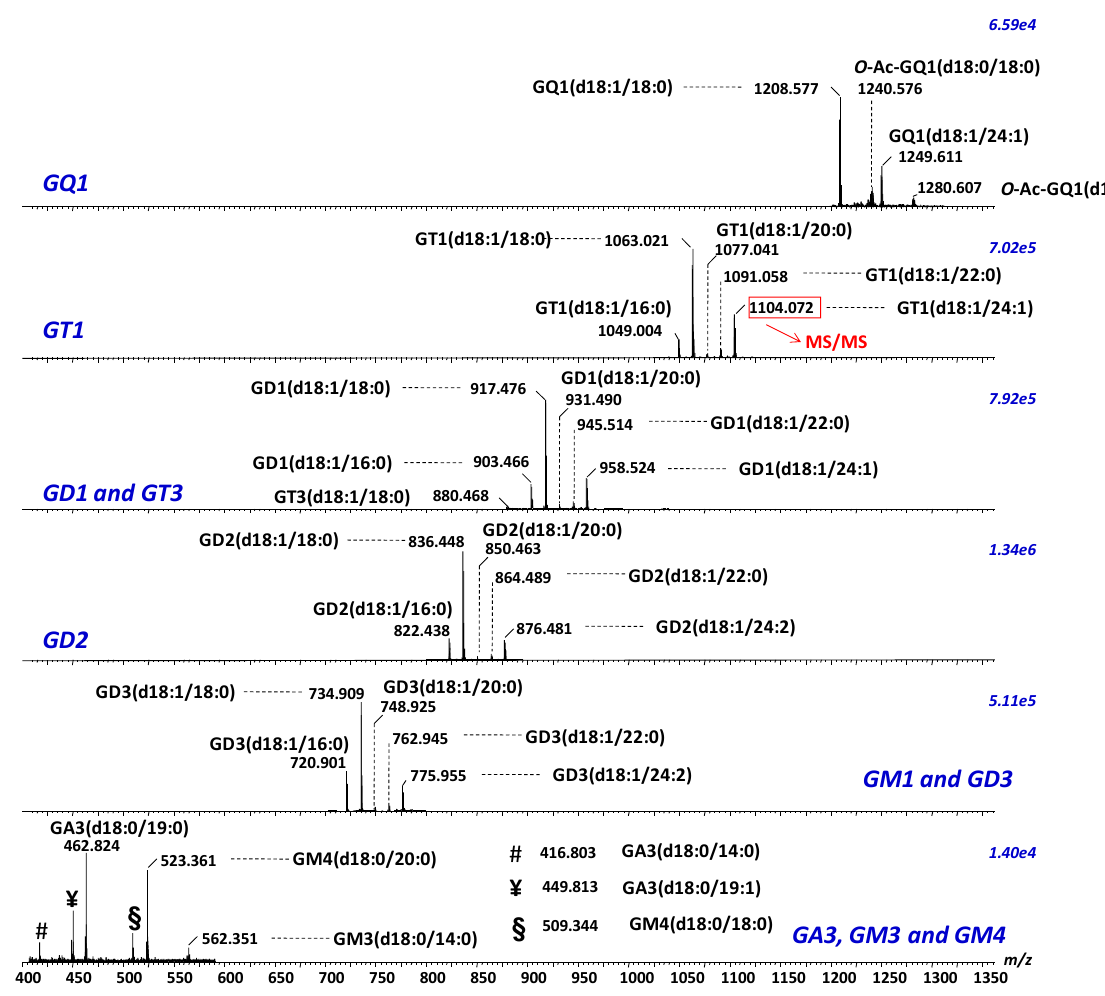
Figure 6. Driftscope display (drift time vs. m / z ) of the total distribution of GG ions from GBM. In the drift cell, GG ions were separated based on the charge state, the carbohydrate chain length, the degree of sialylation, and ceramide composition (reprinted with permission from [183]).